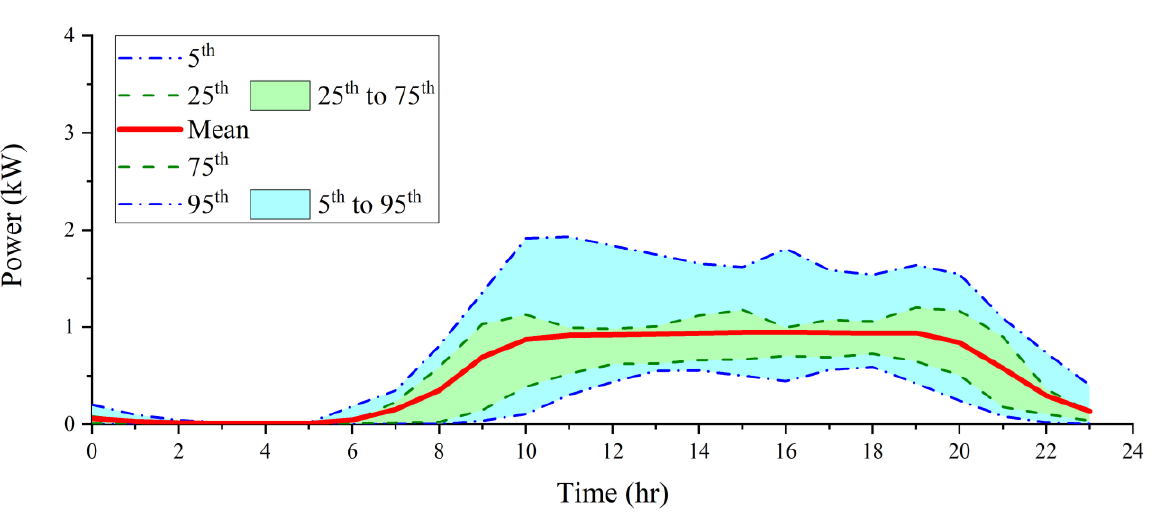
Figure 18. Average annual and seasonal EV charging station daily load profiles (with percentile ranges).